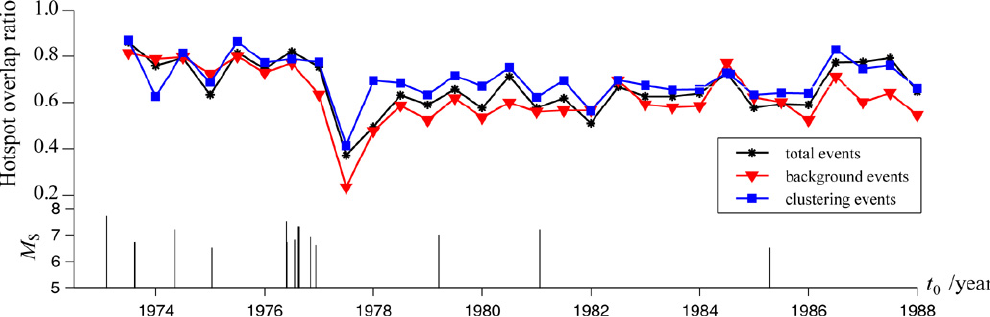
Fig. 6. “Hotspot overlap ratio”, defined as the hotspot pixels overlapped with those of the previous half year (i.e., the last sliding step), represented as the relative value comparing to the whole hotspot pixels, compared with the M − t 0 plot for events larger than M S 6.5.